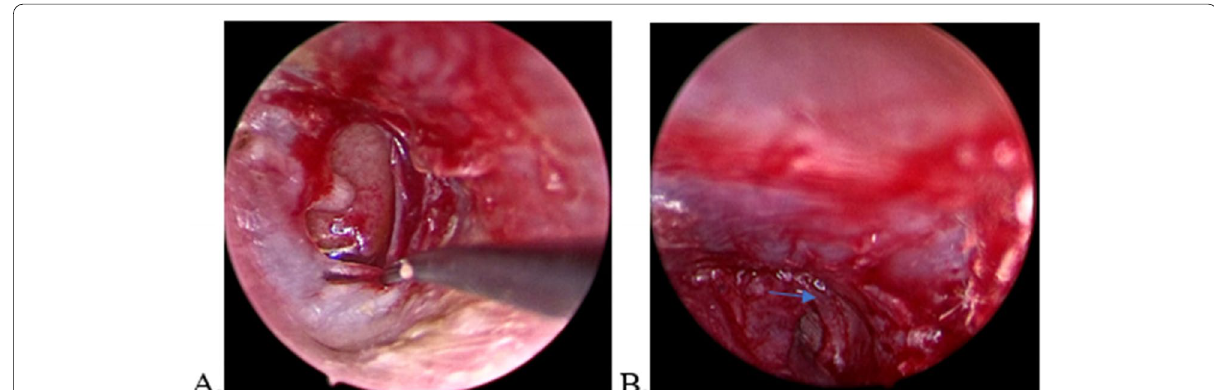
Fig. 4 A Endoscopic trimming of the edge of tympanic membrane perforation. B Good endoscopic view of the anterior edge of the perforation with the ability to adjust the graft in underlay fashion to the anterior edge in narrow EAC. Arrow refers to the anterior edge of the perforation with the endoscopic ability to accommodate the graft in underlay fashion